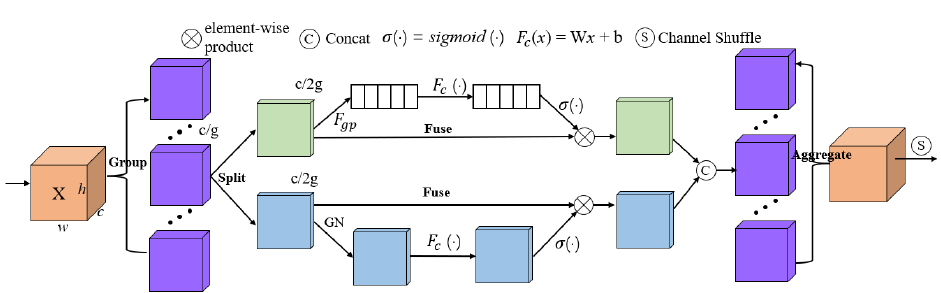
Figure 5. SA-Net structure diagram.